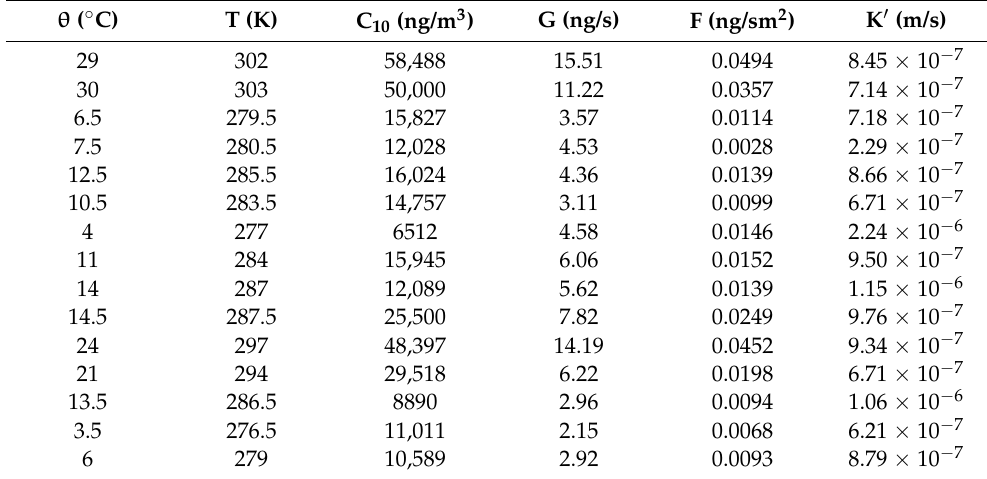
Table 2. Calculation of coefficient K′ (m/s) from concentration C 10 measured at the focus.